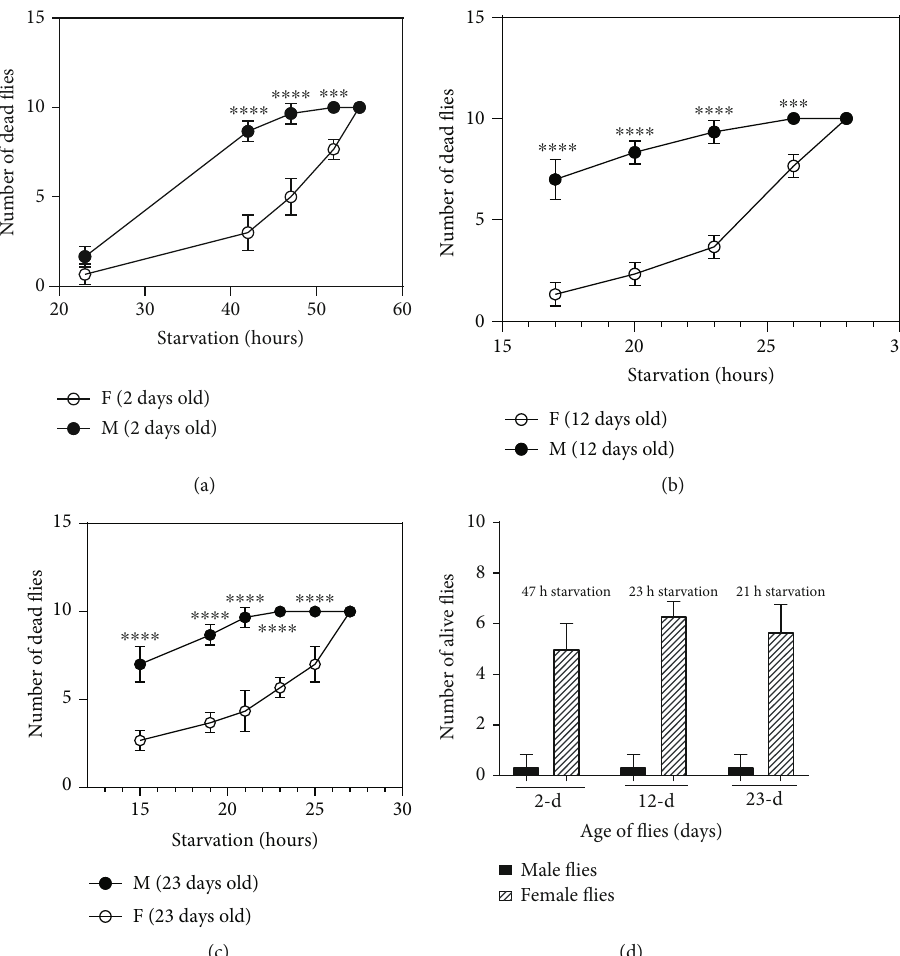
Figure 1: Starvation a ff ects the survival of fl ies based on age and gender. Male (M) and female (F) fl ies of di ff erent ages (2 d, 12d, and 23d) were kept under starvation. The survival of fl ies during starvation was age-dependent: 2d fl ies (a) survived longer than 12d (b) and 23 d (c) male and female fl ies. Similarly, 12 d fl ies (b) survived longer than 23d (c) male and female fl ies. During starvation, male fl ies at all ages died faster than female fl ies of the same age group. (d) The number of fl ies that had survived (out of 10 male and 10 female fl ies) at a speci fi c starvation time period shown. The data is presented as the mean ± SD . It was analyzed by two-way ANOVA with Sidak ’ s multiple comparison test between male and female fl ies. ∗∗∗∗ denotes p < 0 : 0001 , and ∗∗∗ denotes p < 0 : 001